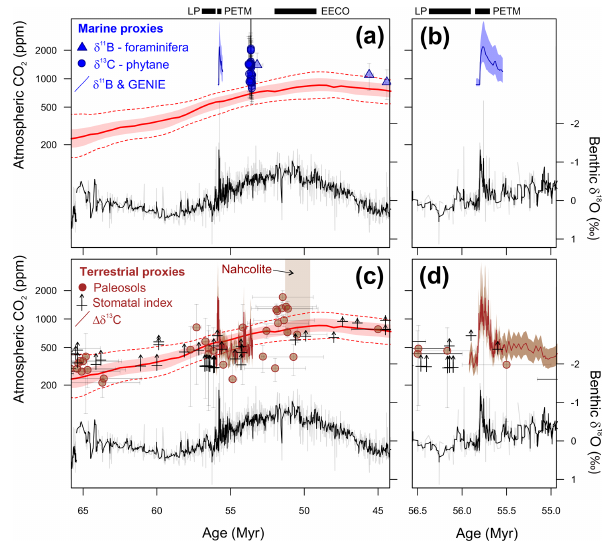
Figure 6. Reconstruction of atmospheric CO 2 from marine ( a and b ) and terrestrial ( c and d ) proxies for the early Paleocene to early middle Eocene ( a and c ), and an expanded reconstruction across the Paleocene–Eocene boundary ( b and d ). The CO 2 estimates plot- ted here are summarized with appropriate references in Supple- ment Data File 8. The red line is a LOESS smoother from Foster et al. (2017), the red band is 68% confidence and the dashed red lines are 95% confidence around that long-term trend. The timescale of Gradstein et al. (2004) is used in this figure. Approximate lo- cations of the three targeted time intervals are also shown: latest Paleocene (LP), Paleocene–Eocene thermal maximum (PETM) and early Eocene climatic optimum (EECO). Note that stomatal index and the nahcolite are plotted with an unbounded upper CO 2 and so represent minimum estimates. See the text for a discussion of the methodologies